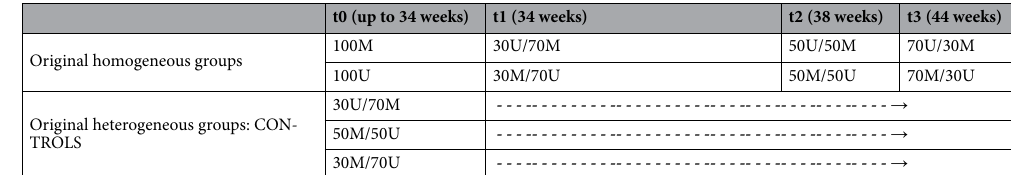
Table 2. Experimental design showing phenotype treatments and their sequential alteration. M marked, U unmarked, t0 initial treatments, t1 1st phenotype alteration, t2 2nd phenotype alteration, t3 3rd phenotype